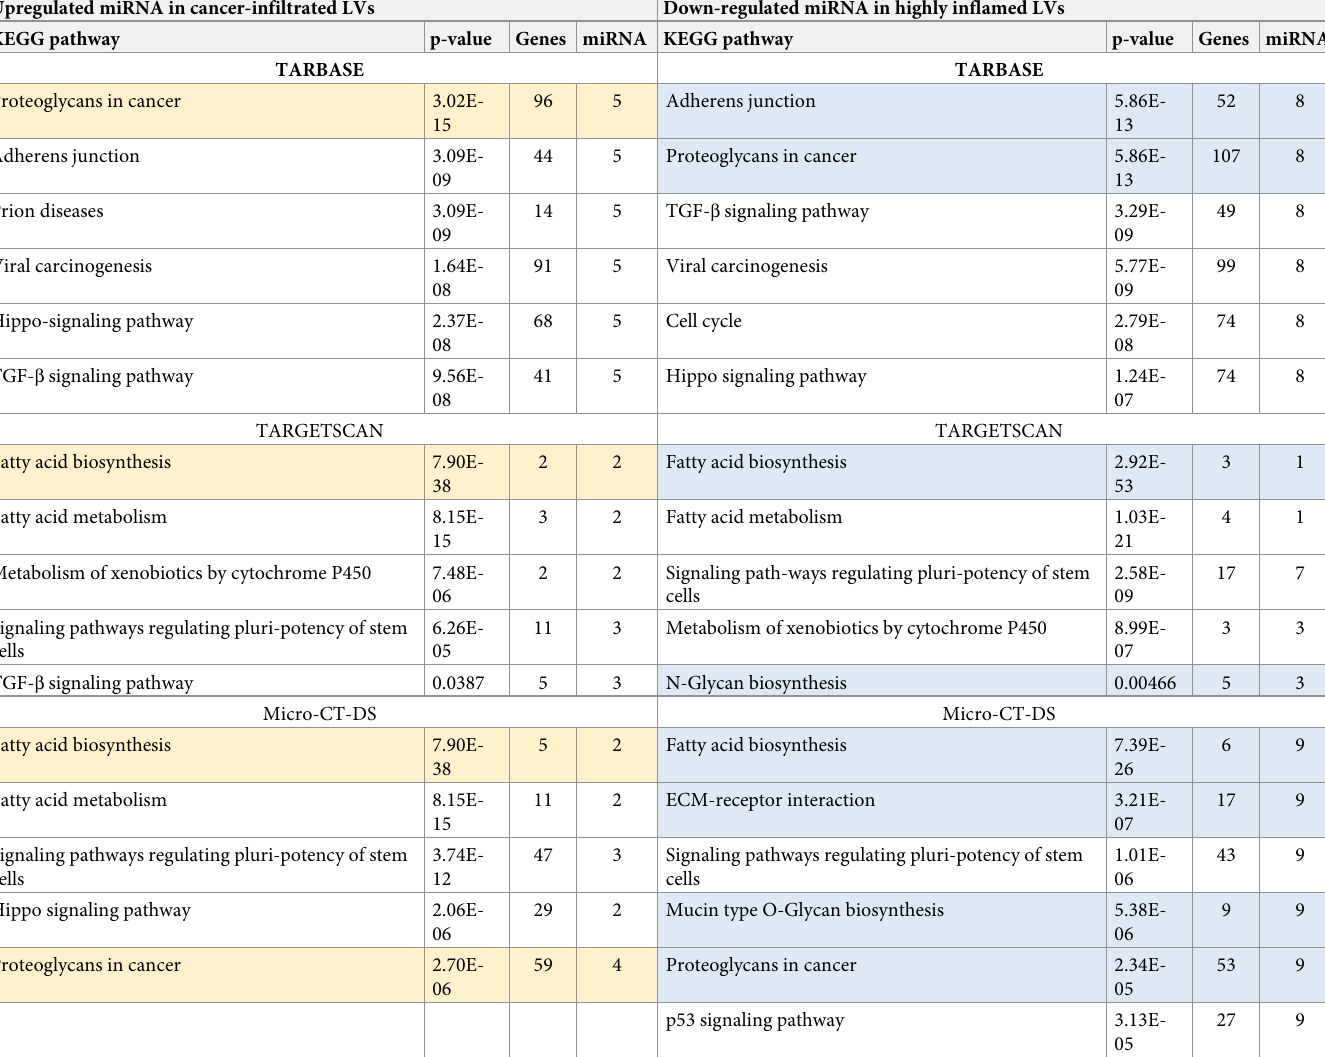
Table 6. Pathway analysis using MiRNA that were significantly up-regulated in cancer-infiltrated LVs (left-hand side) and miRNA significantly down-regulated > 1.8 fold (right-hand side) in highly inflamed LVs. Upregulated miRNA in cancer-infiltrated LVs